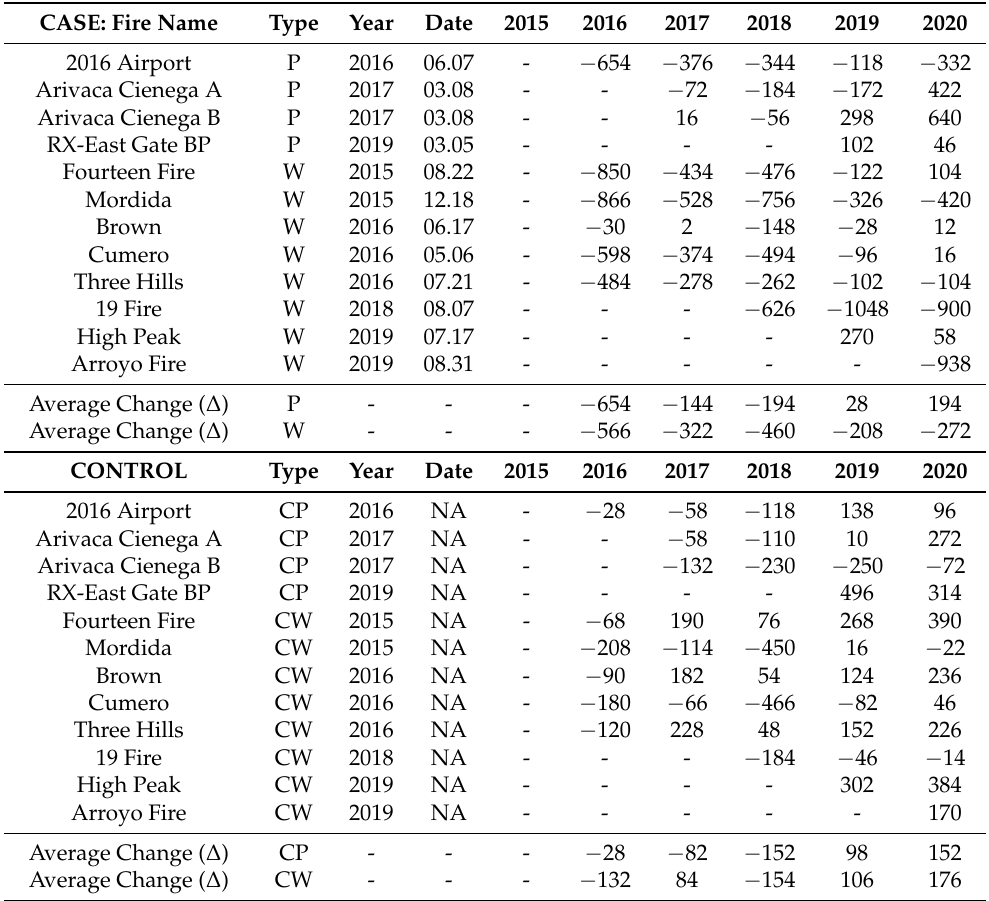
Table A3. The yearly estimated change ( ∆ ) of fine-fuels (kg/ha) within burn perimeters after wildfire (W) and prescribed (P) fires at BANWR against 1-km buffered control (C) areas around fire perimeters (some ignition dates do not align with calendar date but rather to pre- or post-imagery